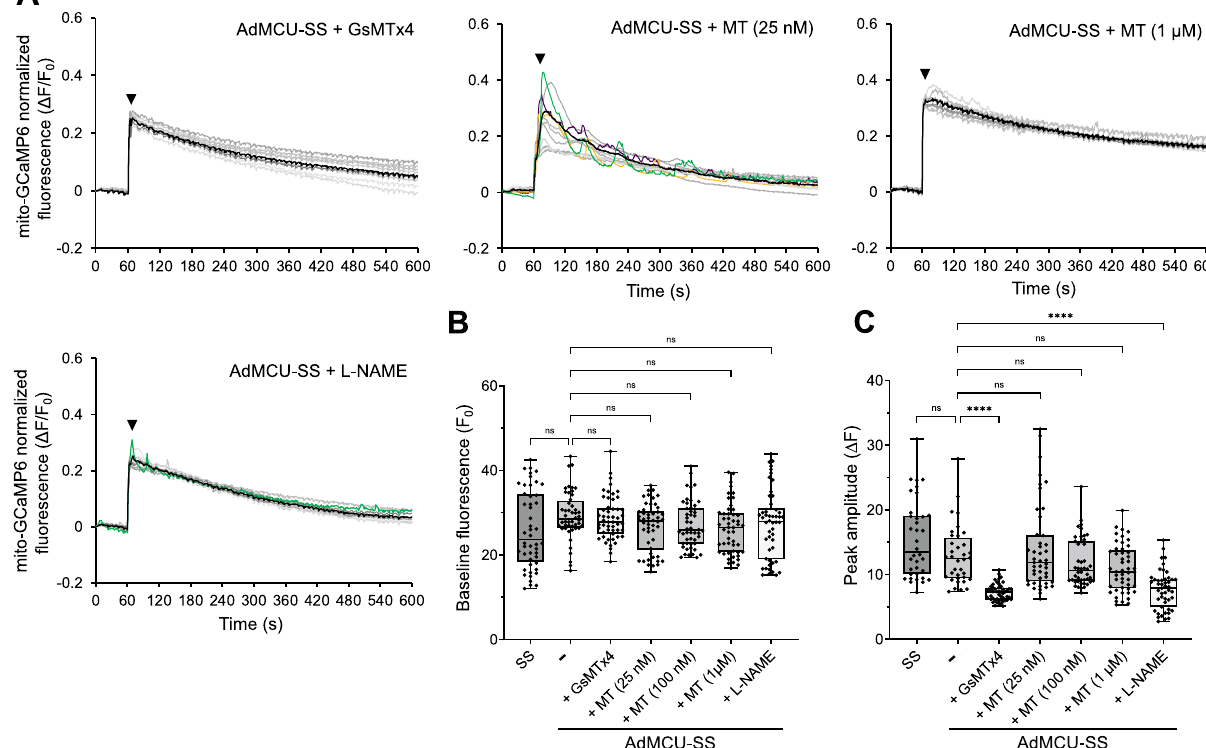
Figure 4. Piezo1-mediated Ca 2+ influx, mROS and NO signaling determine the m Ca 2+ response in sheared MCU OX ECs. ( A ) Characteristic temporal profiles of normalized mito-GCaMP6 fluorescence of MCU OX ECs in a microscope field of view that were exposed to 1 min static followed by 9 min of SS in the presence of either GsMTx4 (5 µM), MT (either 25 nM or 1 µM), or L-NAME (500 µM). The temporal profile of MCU OX ECs in a microscope field of view exposed to the same protocol, but in the absence of any compound, was shown in Fig. 1E. ( B ) None of the tested compounds, GsMTx4, MT (25 nM, 100 nM or 1 µM), or L-NAME, had a significant effect on baseline fluorescence F 0 of sheared MCU-transduced ECs. F 0 of sheared untransduced ECs is also shown. A total of 60 cells (from n = 4 independent experiments) per condition were analyzed. ( C ) GsMTx4 and L-NAME, but not MT, significantly decreased the peak magnitude ΔF (right after the onset of SS) of sheared MCU-transduced ECs. ΔF of sheared untransduced ECs is also shown. A total of 60 cells (from n = 4 independent experiments) per condition were MT concentration, even in untransduced ECs (Fig. 5A). Last, L-NAME significantly inhibited the percentage of ECs with [Ca 2+ ] m oscillations, confirming the role of NO in the m Ca 2+ response of sheared MCU-transduced ECs (Fig. 5A). In continuing with the quantitative analysis of [Ca 2+ ] m transients in the absence and presence of each of the compounds, ECs that exhibited transients from n = 4 independent experiments per condition were binned according to their total number of transients: All the ECs with transients (~ 20% of total cells) from the untrans- duced (or βGal-transduced) monolayers showed 1–2 transients during the 9 min SS, excluding the initial peak at the onset of SS (Fig. 5B). In contrast, less than half of the MCU-transduced ECs with transients had 1–2 transients. The rest of them exhibited a higher number of transients (up to 25) during the 9 min of SS, with most cells having 3–5 transients (Fig. 5B). Each compound tested on MCU OX ECs was found to inhibit the percent- age of ECs with higher than 1–2 transients, with the low MT concentration being the least effective (Fig. 5B). To examine the distribution of transients over time under SS, the total number of transients per cell for all 60 cells in n = 4 independent experiments per condition was binned over 60 s intervals: It was found that the tran- sients persisted with time under SS in the MCU-transduced ECs at a rate of ~ 0.6 transients/min (Fig. 5C). Each compound tested, except for the low MT dose, blocked the formation of transients with increasing time under SS (Fig. 5C). Last, from the total number of transients and the SS duration (9 min), a [Ca 2+ ] m oscillation frequency was calculated for each condition: A frequency of ~ 10 mHz was calculated for sheared MCU OX ECs, and each compound tested significantly decreased that oscillation frequency (Fig. 5D). The oscillation frequencies for sheared MCU-transduced in the presence of either GsMTx4, MT (100 nM and 1 µM), or L-NAME were not sig- nificantly different from the frequency calculated for sheared untransduced (or βGal-transduced) ECs (Fig. 5D).